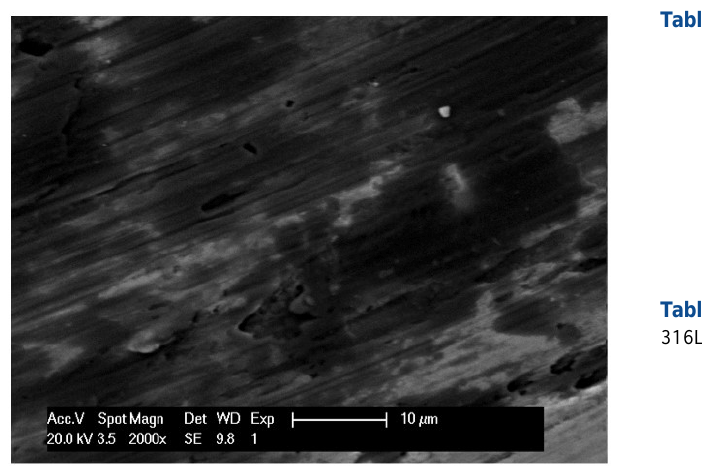
Figure 3. SEM image of the surface of the steel substrate. The lighter regions are less conductive and may indicate that these re- gions are of higher carbon content due to the use of a carbide-cutting tool to form the surface.